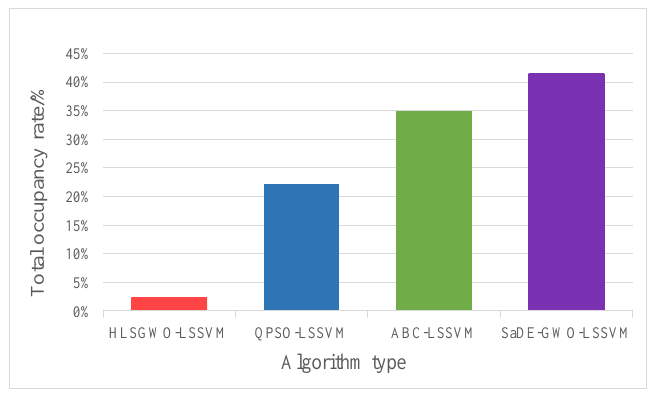
Figure 7. The resource occupancy of power prediction.